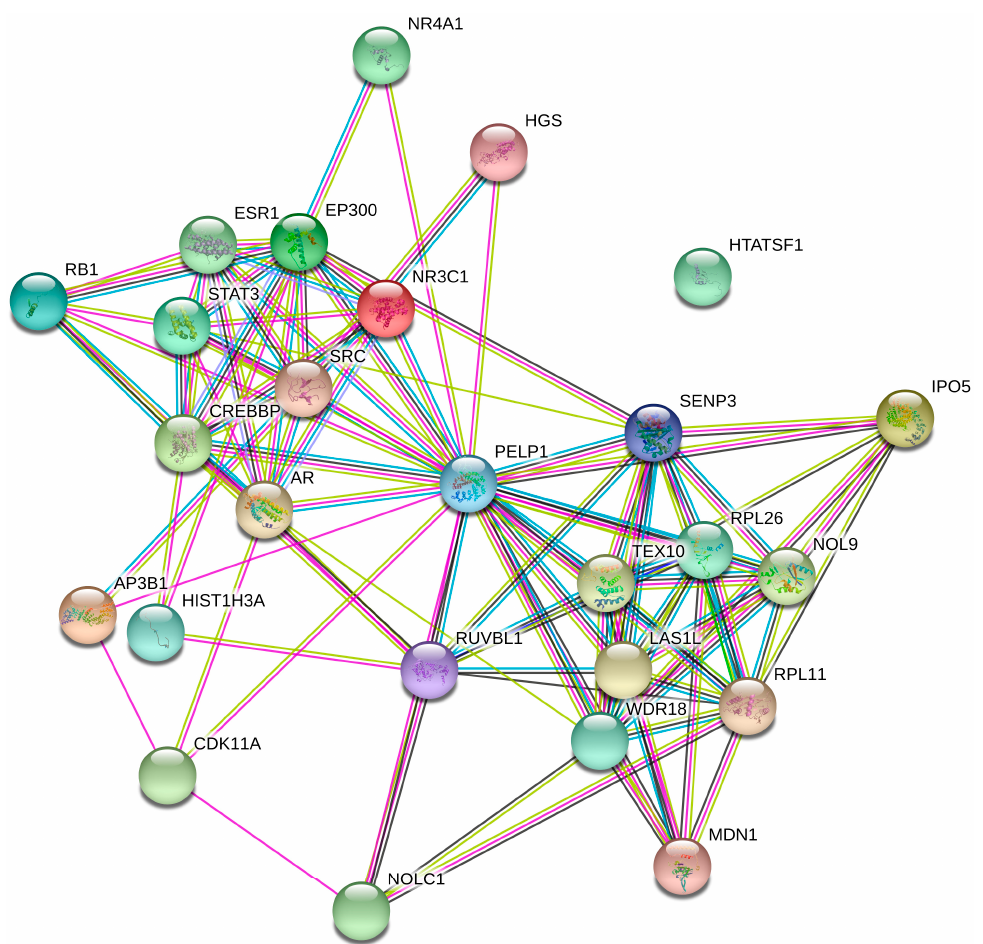
Figure 5. PPI network of PELP1. This figure displays data obtained from three databases and illustrated using STRING.